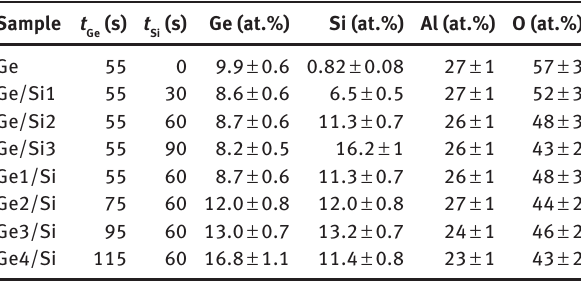
Table 1: Ge and Si deposition times and atomic percentages for all